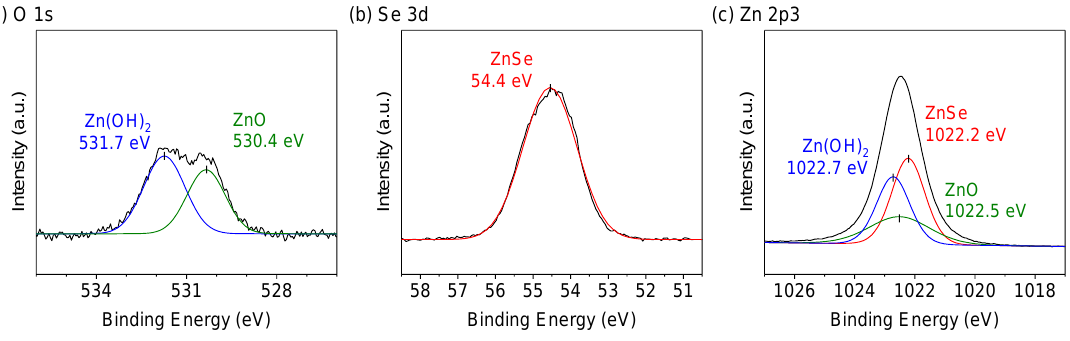
Figure 11. For a Zn(Se,OH) film deposited with NH 4 OH concentration of 1.2 M after sputtering for 120 s, ( a ) the oxygen 1s; ( b ) the selenium 3d, and ( c ) the zinc 2p3 photoelectron binding energy spectra.